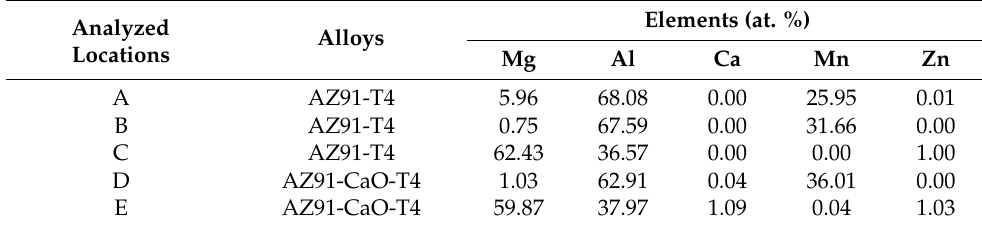
Table 1. EDS result of AZ91-T4 and AZ91-CaO-T4 in Figure 2. Analyzed